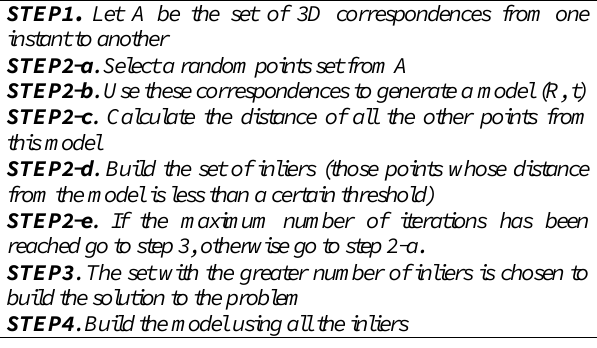
Table 3: inliers